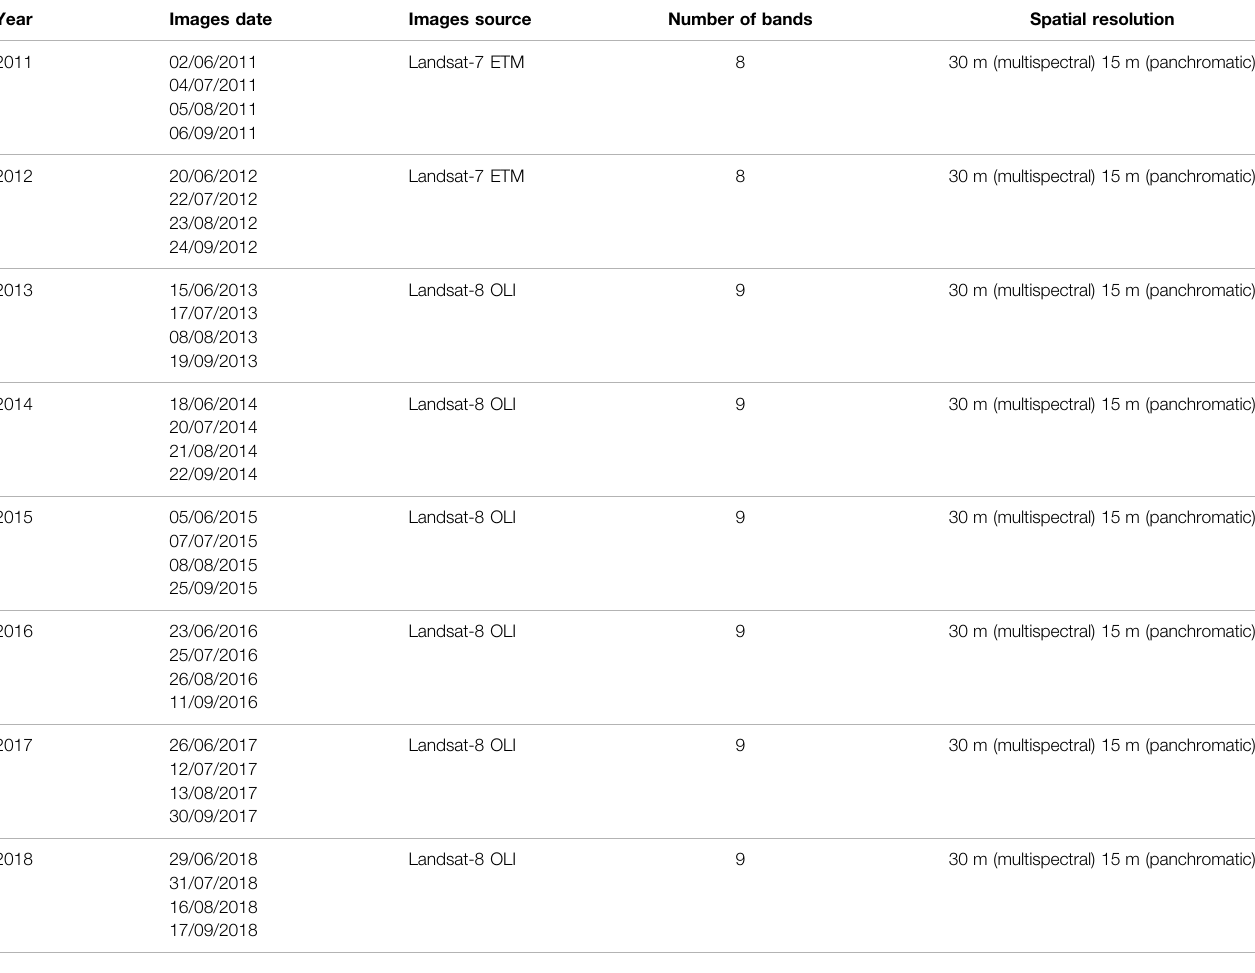
TABLE 1 | Summary of the remote sensing images used in this study.